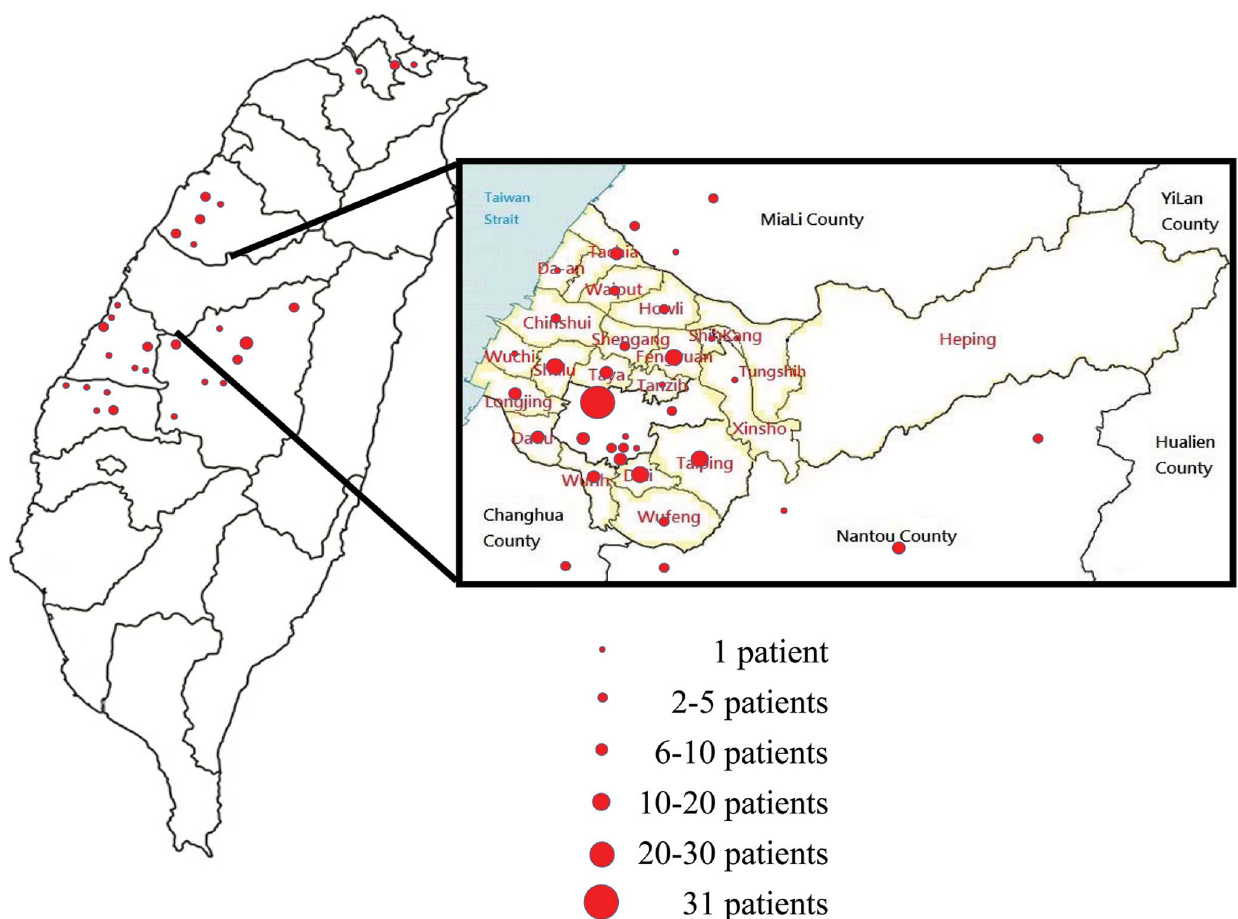
Figure 1. Geographic distribution of EV71-infected patients participated in this study from 2002 to 2012 in Taiwan.